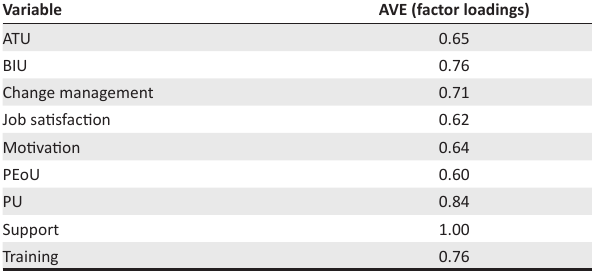
TABLE 2: Average variance loadings – model factors